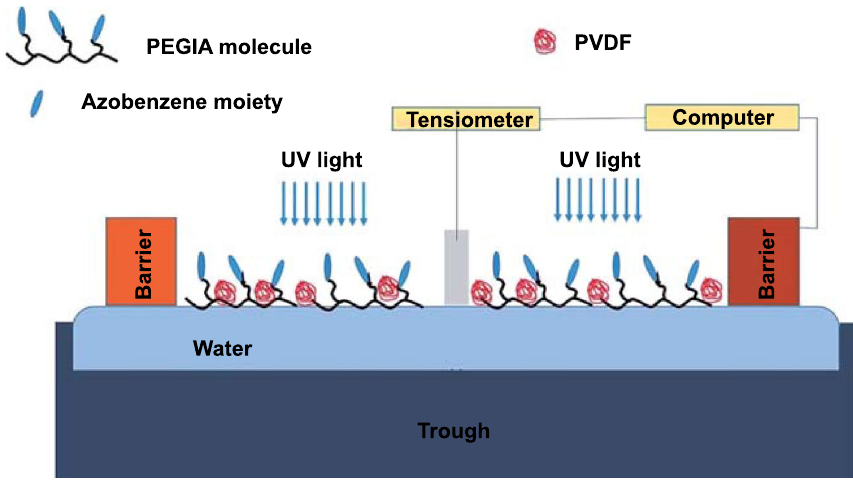
Fig. 19 Mechanism of the effect of local electric field on trans – cis photoisomerization of azobenzene containing PEGIA